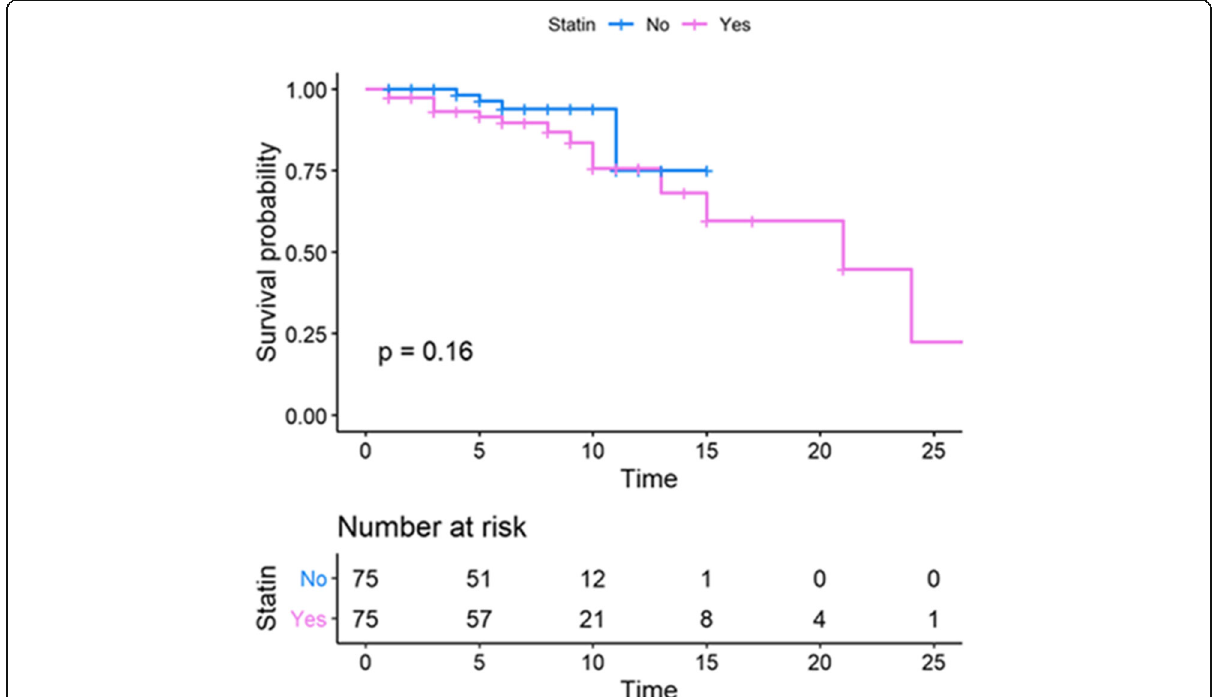
Fig. 3 Kaplan-Meier plot comparing the survival time (in days) between the statin and non-statin groups. This plot suggests that before any adjustment (naive data) mortality was lower in the statin than the non-statin group. However, the P -value of the log-rank test ( P = 0.16) did not indicate any significant